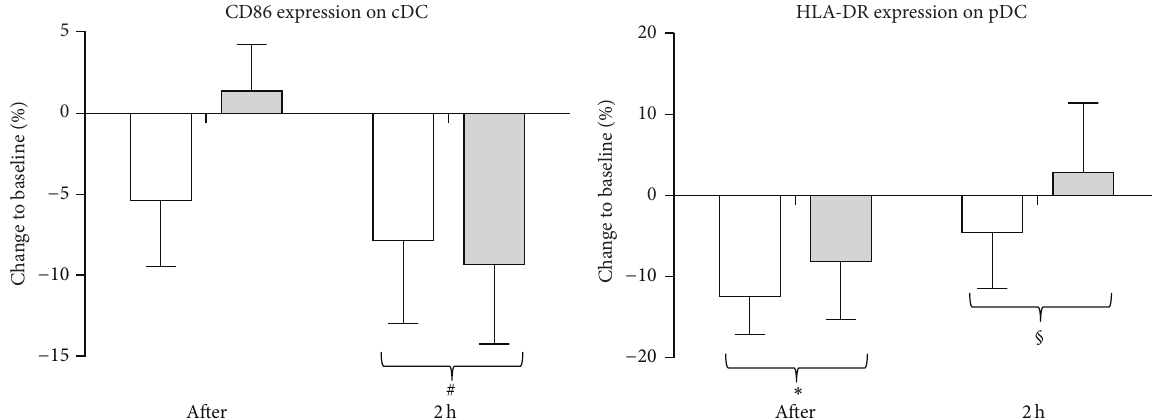
∗∗ Before After 2 h Figure 3: Induction of Flt3L and MMP-9 upon physical exercise. The serum level of Flt3L and MMP-9 was measured by means of ELISA in healthy controls (green dots) and MS patients (red dots). Results are shown as mean concentration ± SEM. Significance ( ∗ 𝑃 < 0.05 ) in the complete population of both patients and controls is annotated by black lines, while green and red lines annotate significance in controls and patients, respectively. Abbreviations used are as follows: MS: multiple sclerosis; Flt3L: Fms-related tyrosine kinase 3 ligand; MMP: matrix metalloproteinase; before: measurement before the exercise test; after: measurement immediately after the test; 2h: measurement 2 hours after the test; and SEM: standard error of the mean.